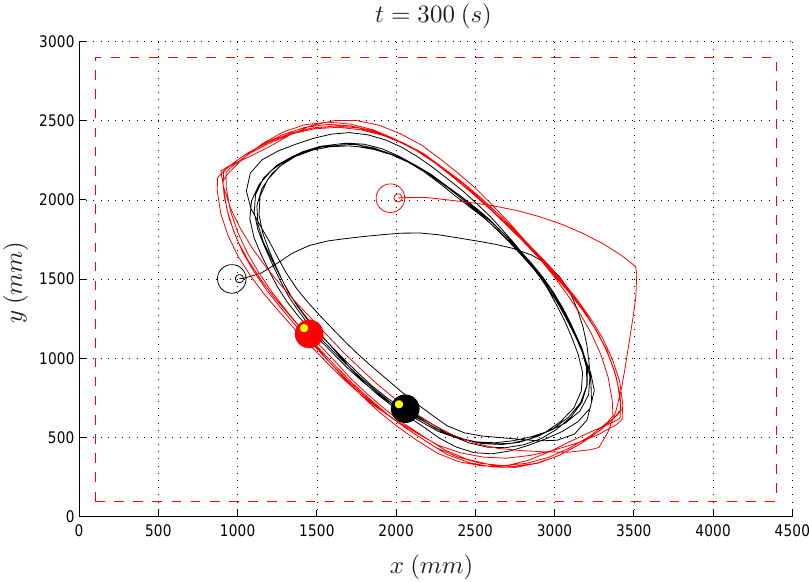
Figure 15. Pursuer-evader games, Algorithm 2: pursuer (black) and evader (red) with a PE speed ratio equal to